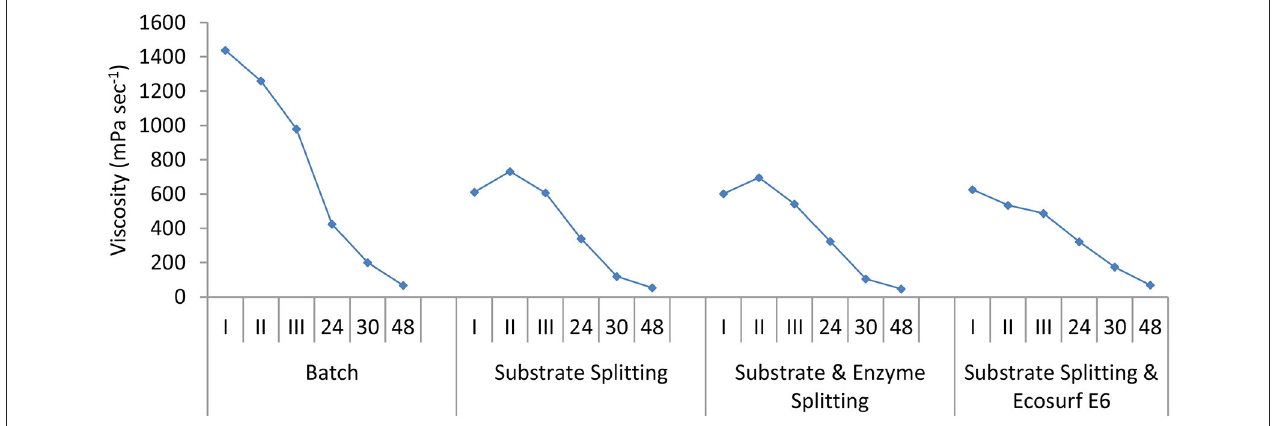
FIGURE 10 | Viscosity changes during hydrolysis under different